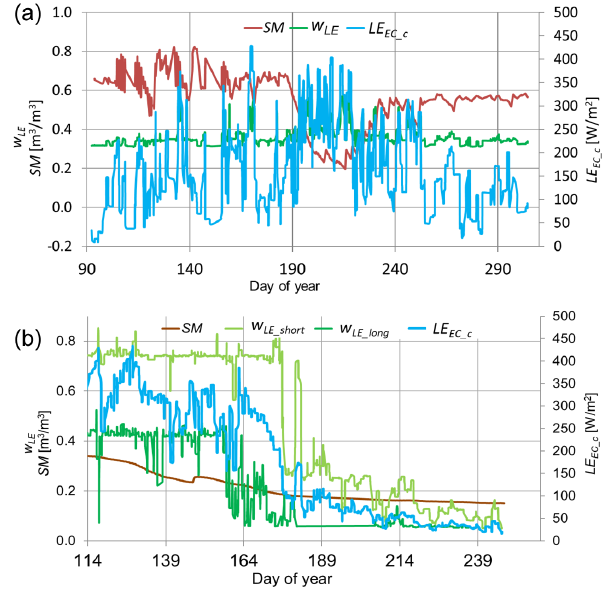
Figure 8. (a) Development of w LE (smoothed, dark green), LE EC_c (smoothed, blue) and soil moisture (brown) including a dry spell in 2013 for G1, humid. All data shown are measured from 05:00 to 20:00. A moving median filter with a window length of 11h was used for smoothing the w LE and LE data. (b) Development of w LE (smoothed, light green) results from values measured between 09:00 and 16:00, the lower w LE (smoothed, dark green) results from estimates from 05:00–09:00 and 16:00–20:00 and measure- ments between 09:00–16:00 (see Sect. 2.4), and corrected LE EC_c (smoothed, blue) along with soil moisture (SM, brown) from 21 April to 4 September 2018 for M4, semiarid. A moving median fil- ter with a window length of 11h was used for smoothing the w LE and LE data.